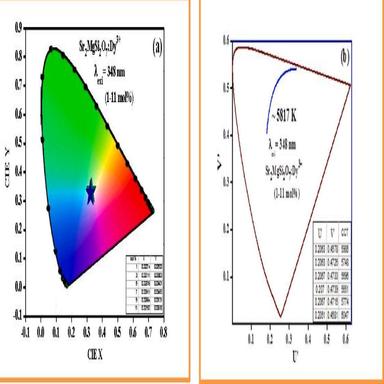
(a). CIE chromaticity diagram and (b) CCT diagram for Sr2MgSi2O7:Dy3þ NPs.